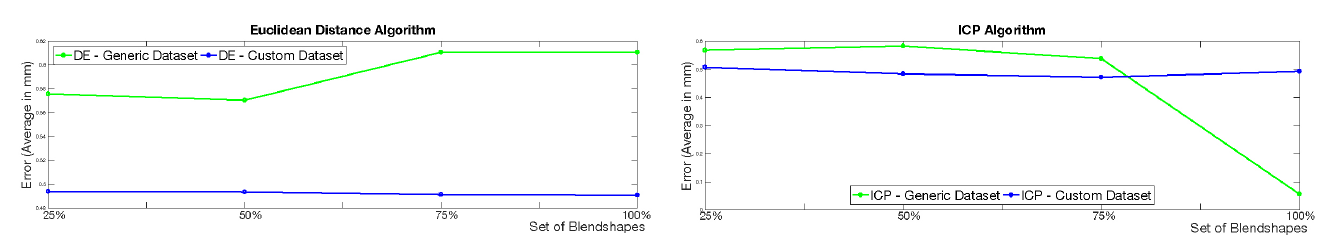
Fig. 17. Graph showing the error difference between the generic dataset and customized dataset processing for the ICP